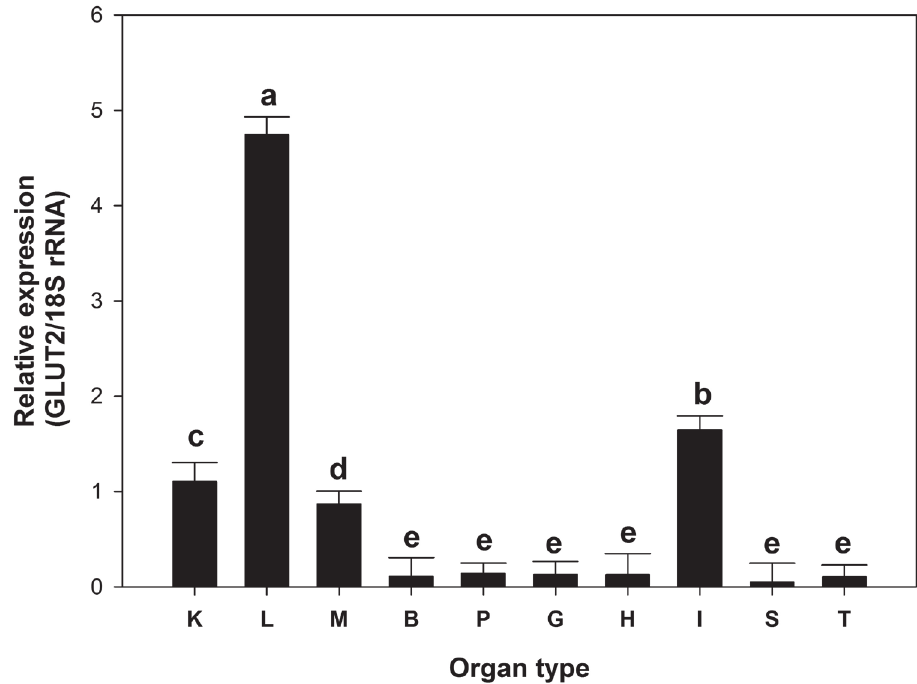
FIGURE 4 | Relative expression of glut2 in kidney (K), liver (L), muscle (M), brain (B), pancreas (P), gill (G), heart (H), intestine (I), stomach (S) and testis (T) of adult Petenia splendida (mean ± SEM; n = 3). Lowercase letters indicate significant differences between the expression level in the tissues (p <